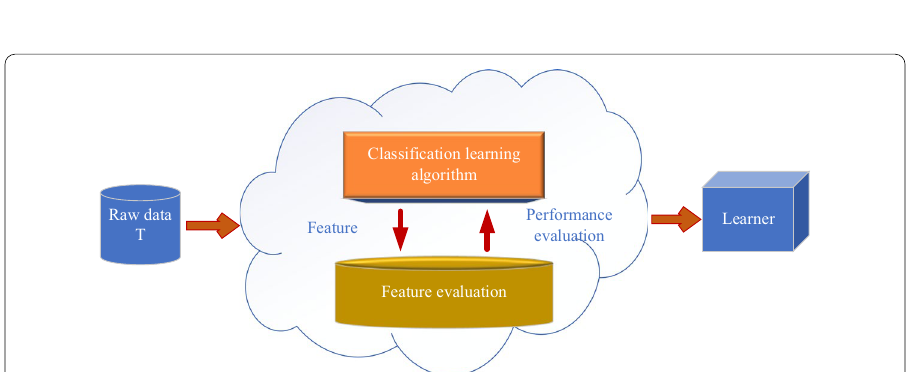
Fig. 7 Working principle of embedding